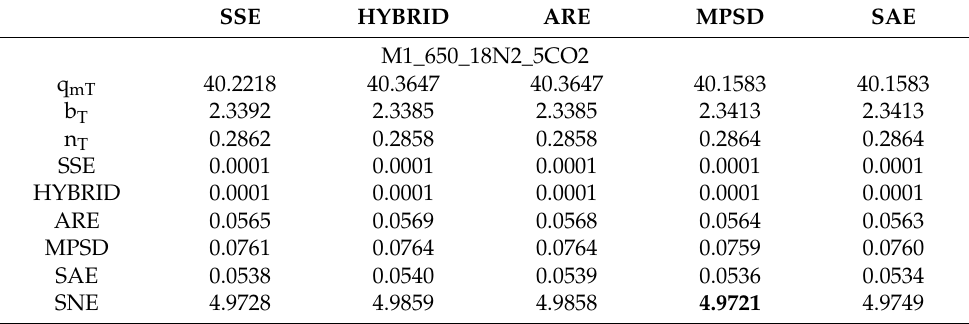
Table 6. Toth isotherms constants with error analysis